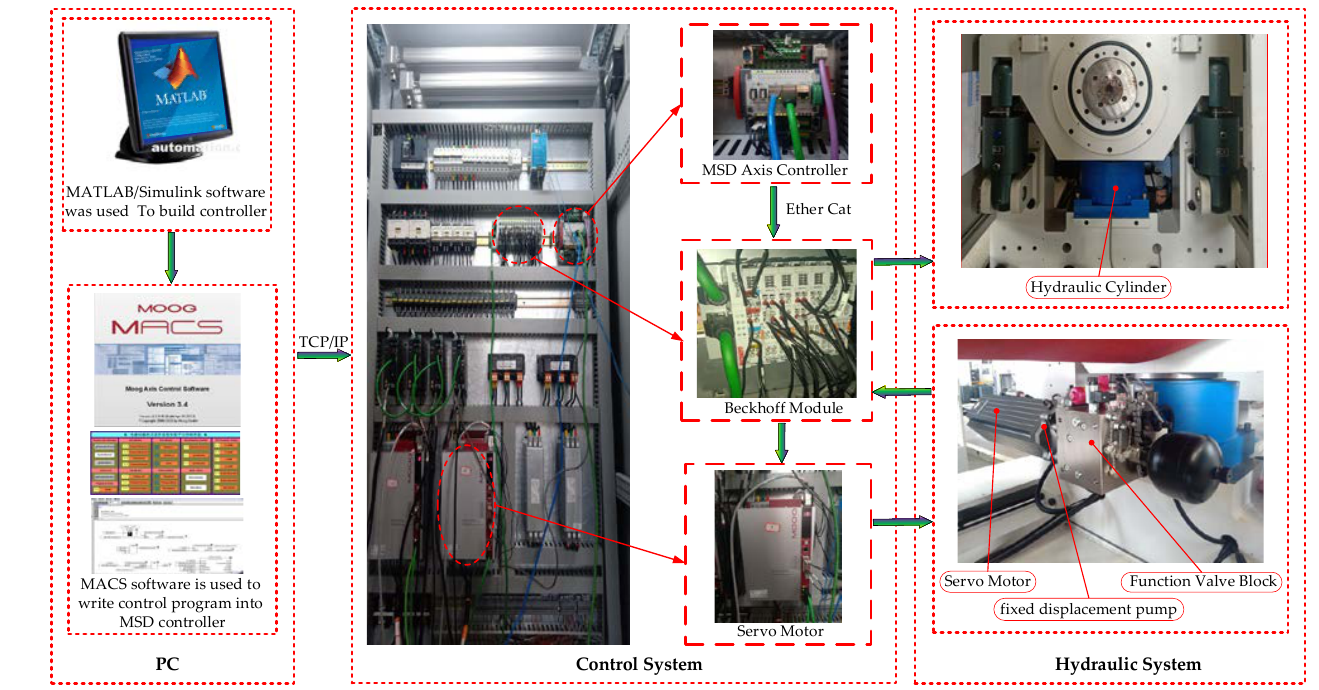
Figure 10. Rolling mill pump control AGC control frame. Table 1. Operating parameters of experimental